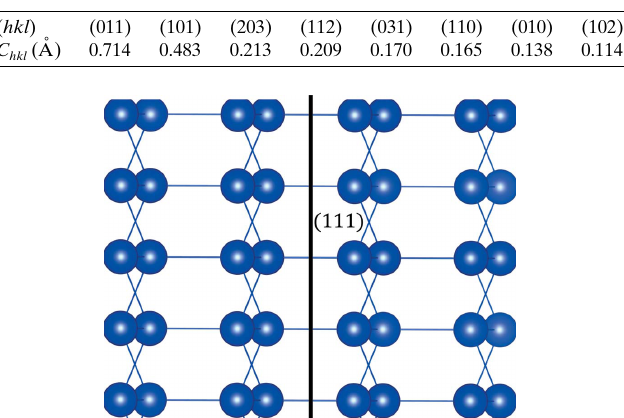
Figure 8 The structure of silicon viewed along the (111) plane. The [111]* reciprocal lattice direction is horizontal. The figure exposes the corresponding structural gap (as also appears in Fig. 7).